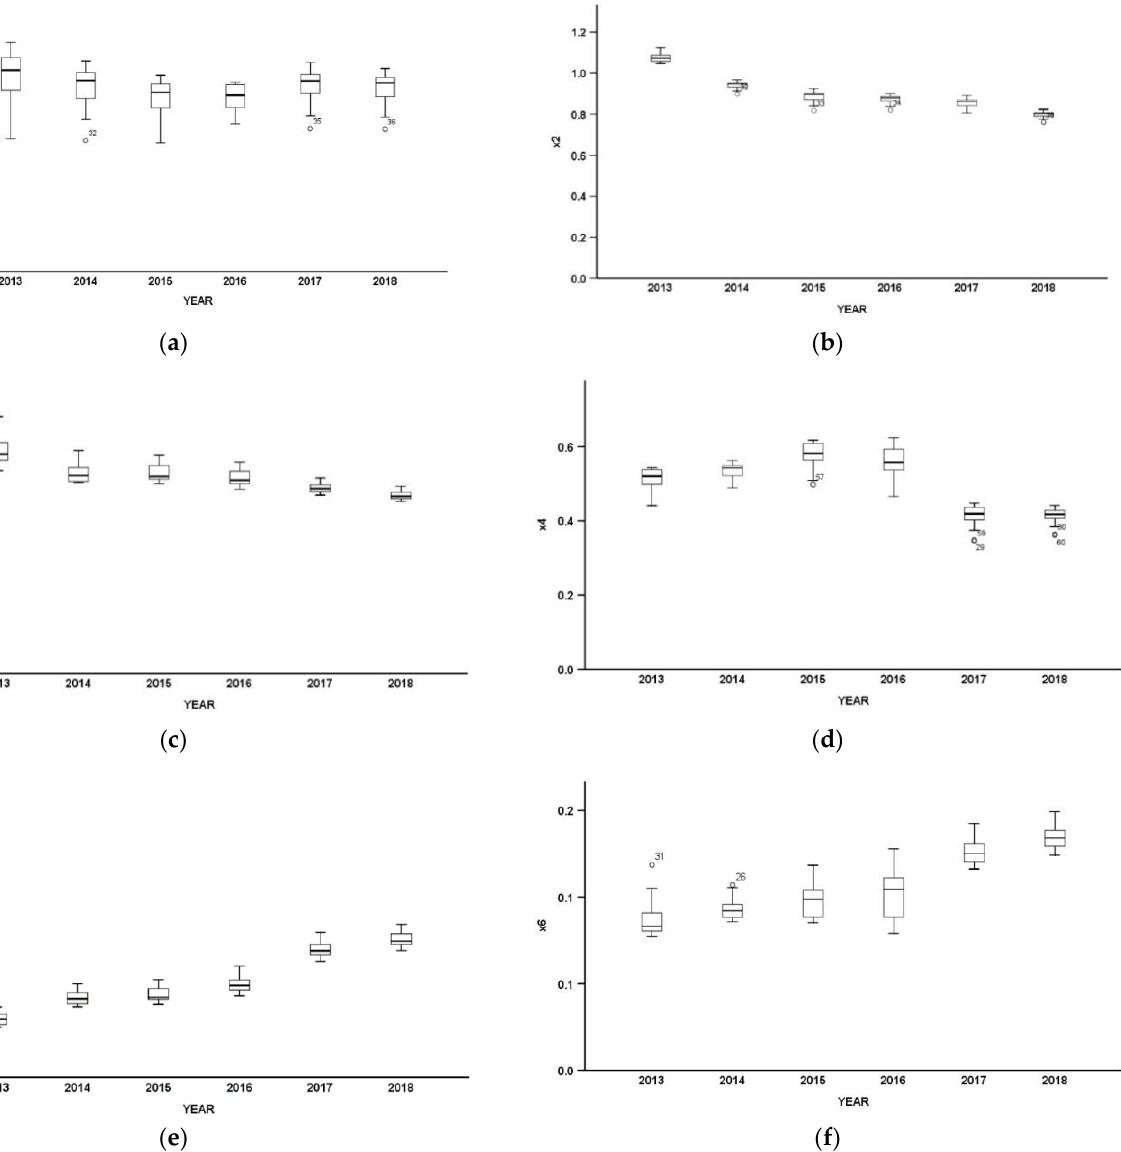
Figure 4. ( a ) Temporal heterogeneity of PGTWR regression coefficients of industrial structure; ( b ) Temporal heterogeneity of PGTWR regression coefficients of urbanization level; ( c ) Temporal heterogeneity of PGTWR regression coefficients of energy intensity; ( d ) Temporal heterogeneity of PGTWR regression coefficients of level of economic development; ( e ) Temporal heterogeneity of PGTWR regression coefficients of population size; ( f ) Temporal heterogeneity of PGTWR regression coefficients of opening up.